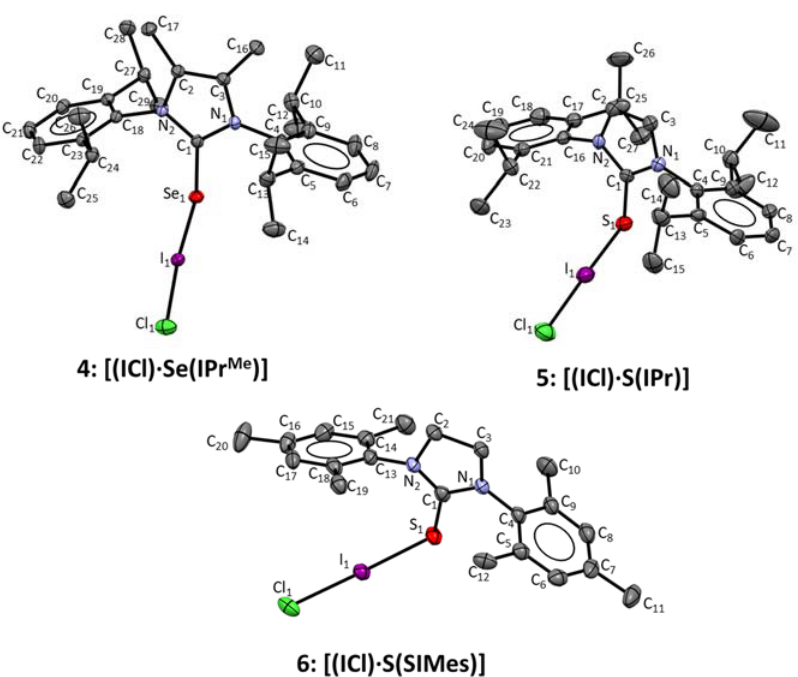
Figure 2. Molecular structures of [(ICl) · Se(IPr Me )] ( 4 ), [(ICl) · S(IPr)] ( 5 ), and [(ICl) · S(SIMes)] ( 6 ) with atom-labeling scheme of all non-hydrogen atoms and thermal displacement ellipsoids drawn at the 50% probability level. Hydrogen atoms and all solvent molecules are omitted for clarity.